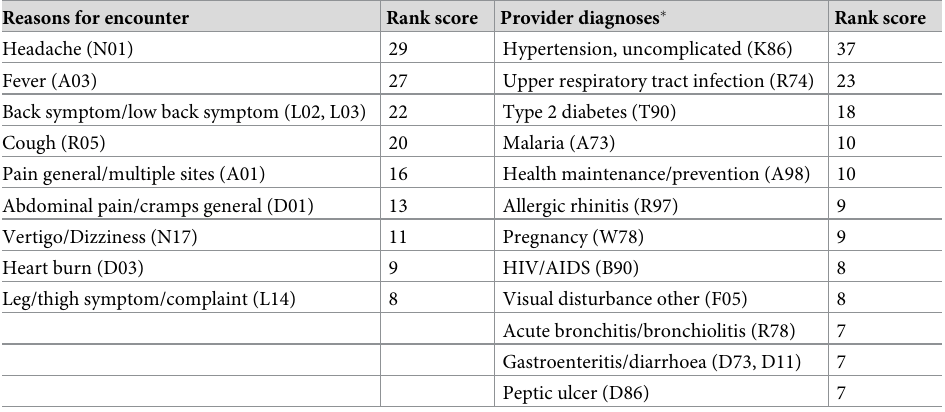
Table 3. Top nine reasons for encounter and top 10 provider diagnoses in adults coded with ICPC-2, based on four